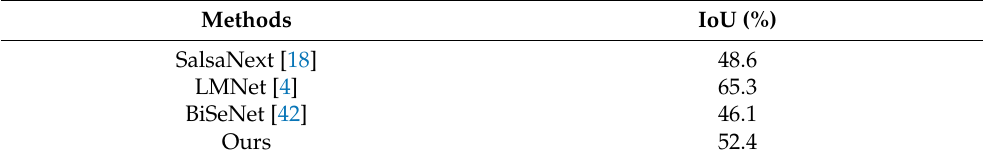
Table 2. MOS performance compared to the state-of-the-art on the SemanticKITTI validation